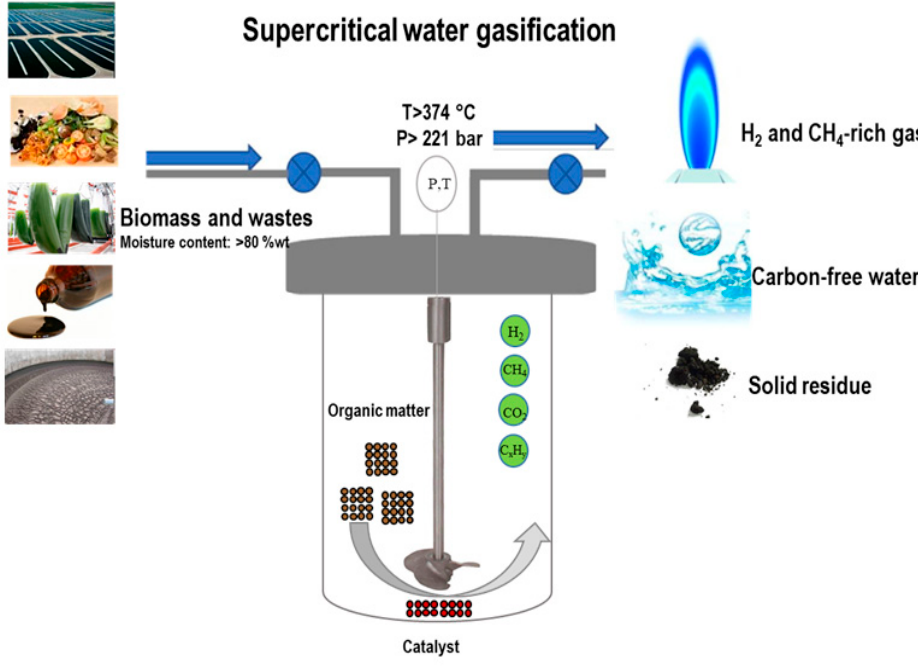
Figure 1. Supercritical water gasification process (so-called hydrothermal